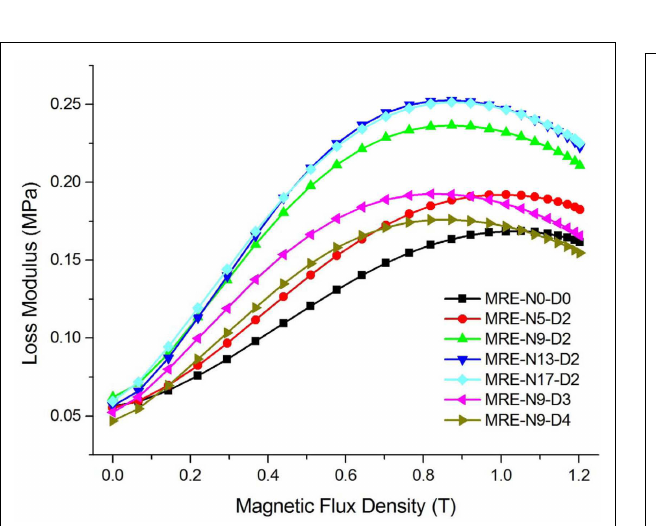
FIGURE 8 | Loss modulus of MRE samples under different magnetic fields .